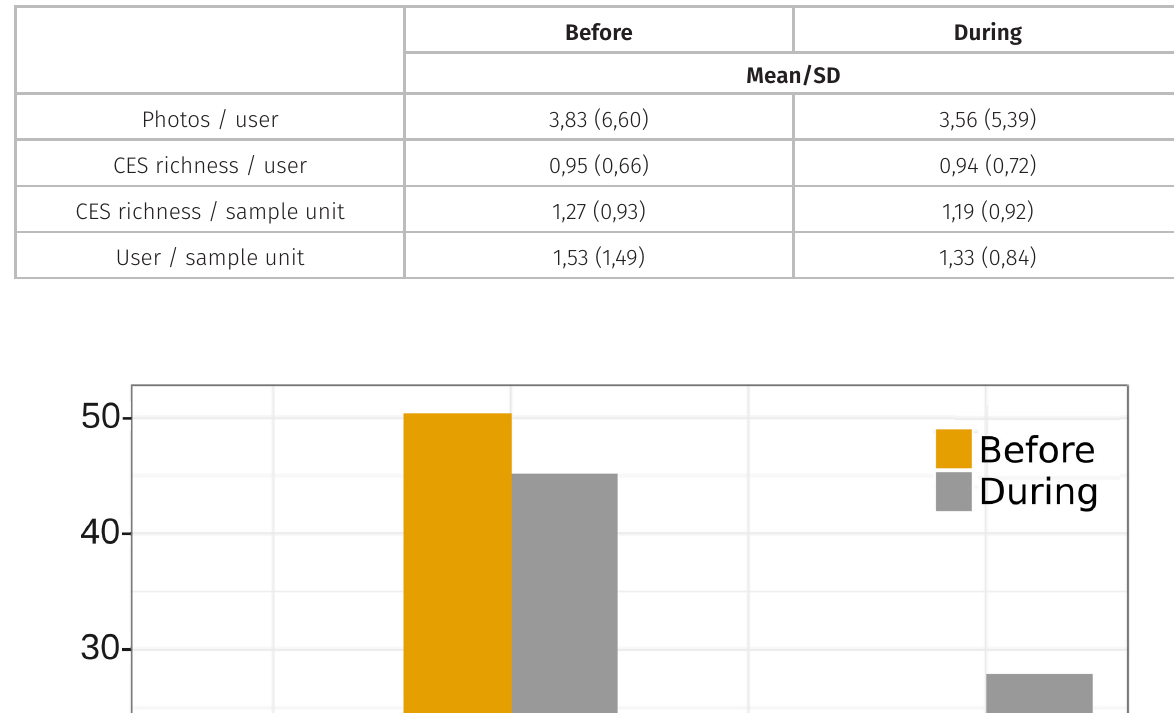
Table I. Photos, Users and Culture Ecosystem Services richness/count in sample units between the periods before and during the oil spill